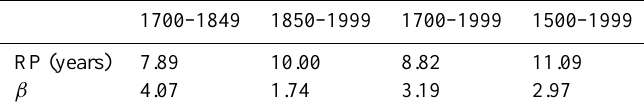
Table 3. As Table 2, for class 2